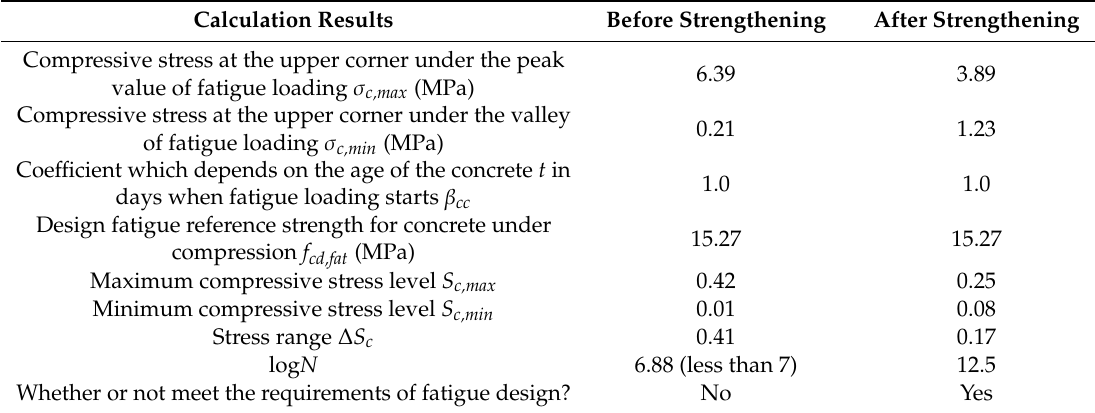
Table 6. Fatigue verification of concrete above the windward-side T-shaped